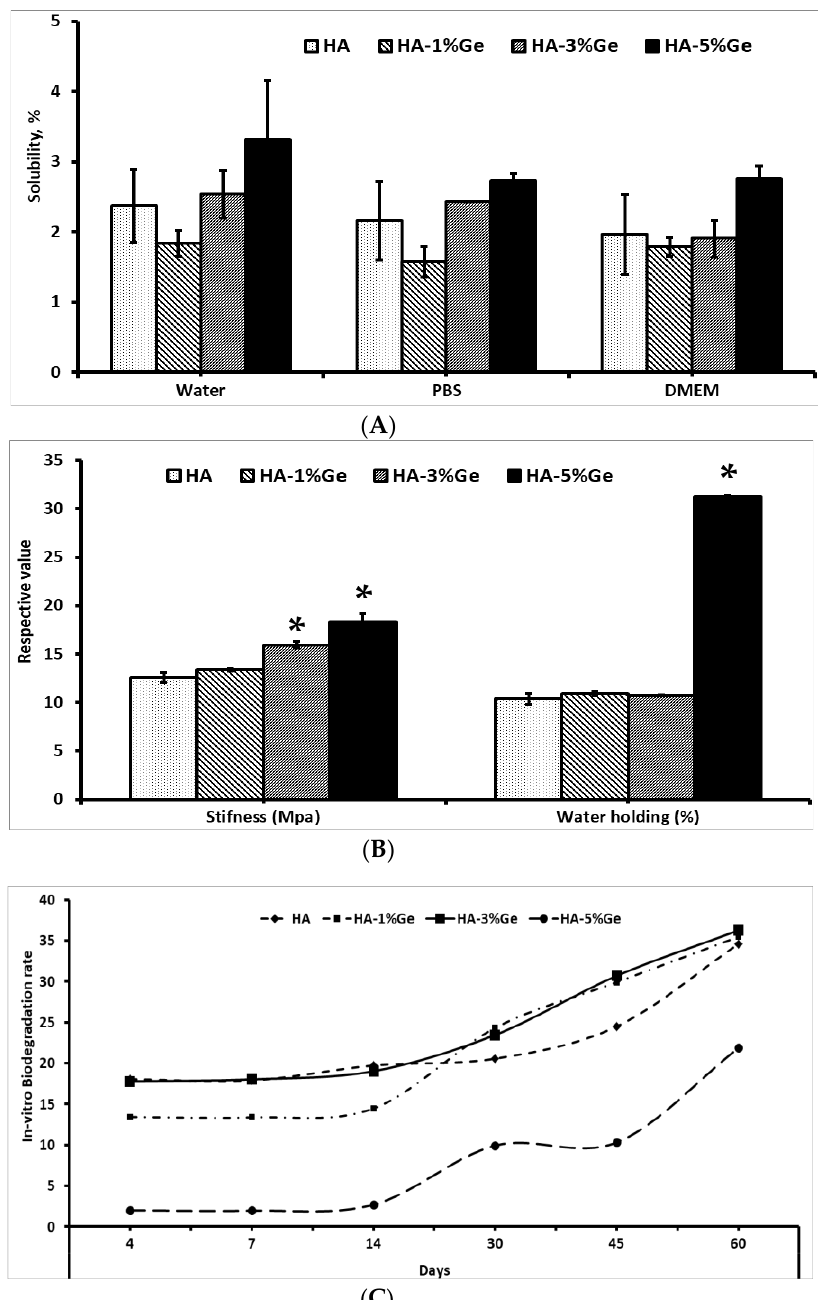
Figure 1. Solubility ( A ), stiffness, water holding ( B ) and in vitro biodegradation ( C ) of HA-Ge biomaterials. HA-control, HA 1% Ge: HA with 1% germanium, HA 3% Ge: HA with 3% germanium, and HA 5% Ge: HA with 5% germanium. * denotes statistical significance, p <0.05 vs. HA.